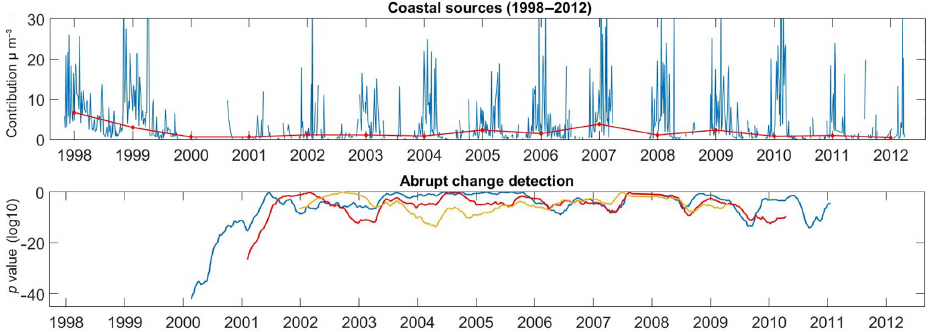
Figure 8. Top panel: time series of coastal sources contributions to PM 2 . 5 and the annual median in red. Bottom panel: p value from a Mann–Whitney hypothesis test comparing the median of both halves of a sliding window, repeated for three different window lengths (320, 480 and 640 days for blue, red and yellow,